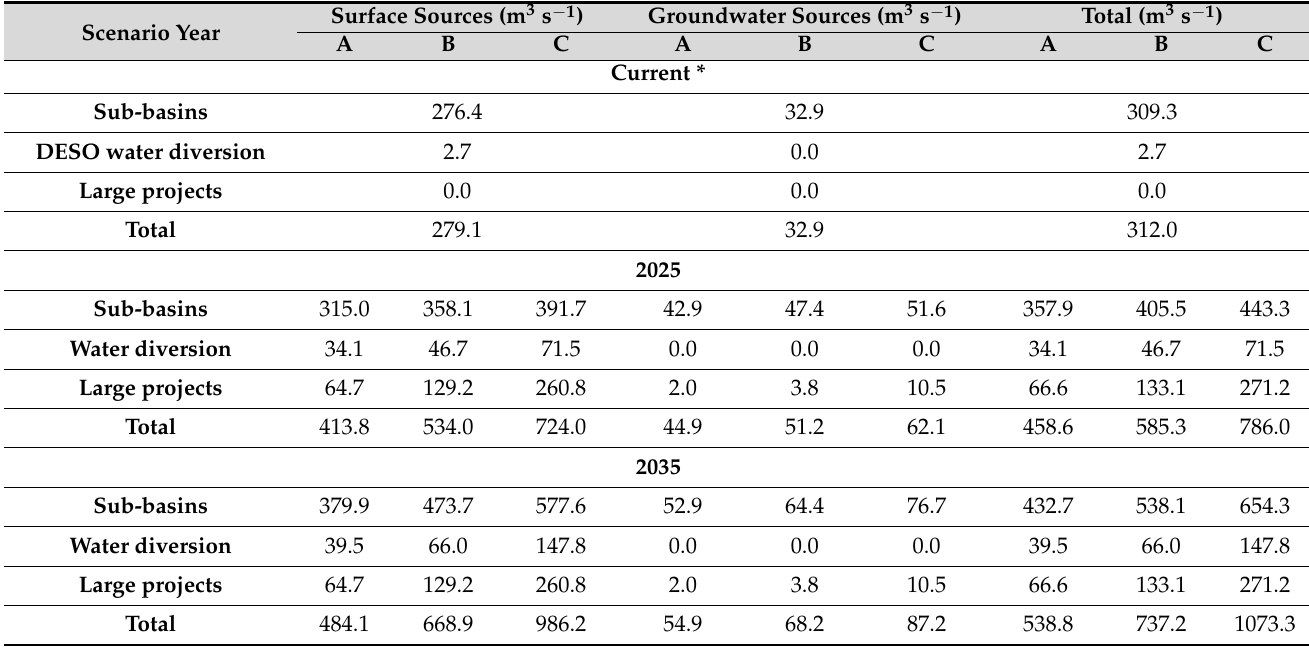
Table 1. Water withdrawal flow projections for consumptive uses to be satisfied by surface and groundwater sources, by year and scenario (average annual flow in m 3 s − 1